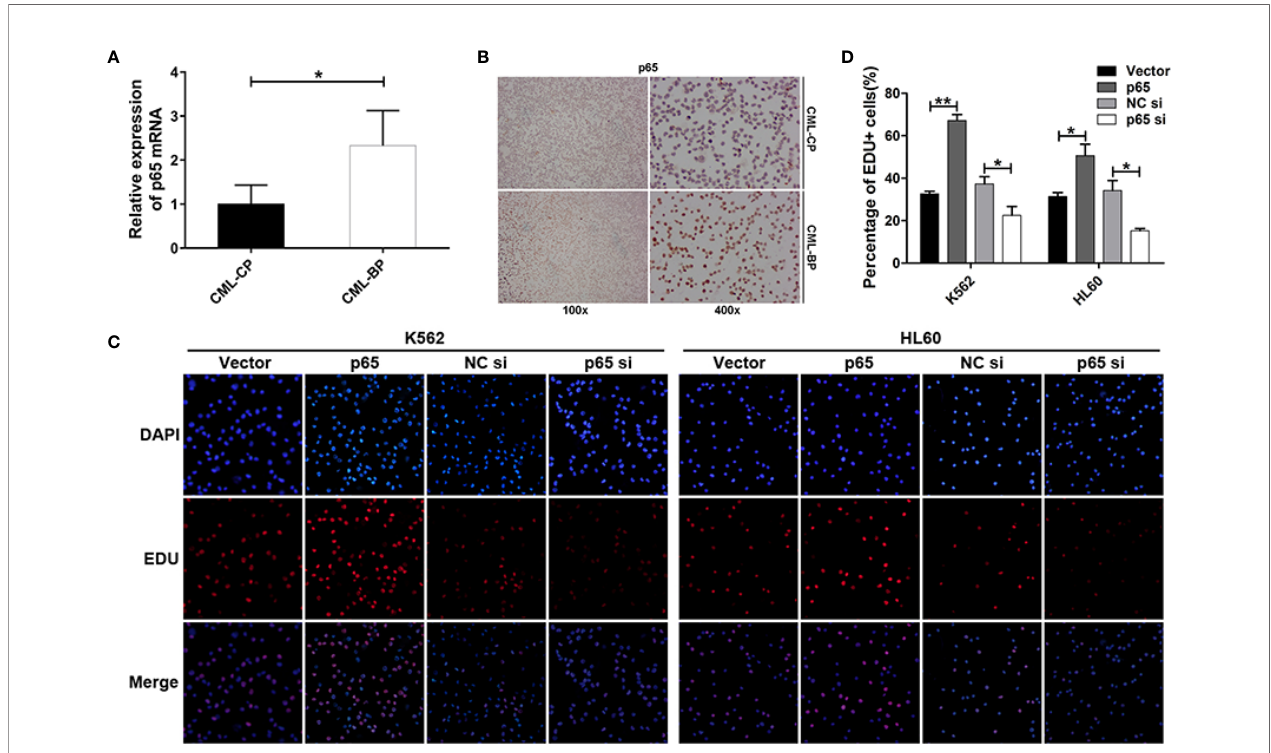
FIGURE 4 | p65 is overexpressed in CML-BP and promotes leukemia cell proliferation. (A, B) qRT-PCR and Immunostaining analysis of p65 mRNA and protein levels in bone-marrow samples from patients with CML-CP and CML-BP. (C, D) EDU of K562 and HL60 cells following transfection with p65 plasmid or siRNA. The results were con fi rmed by 3 independent experiments. * p < 0.05, ** p <